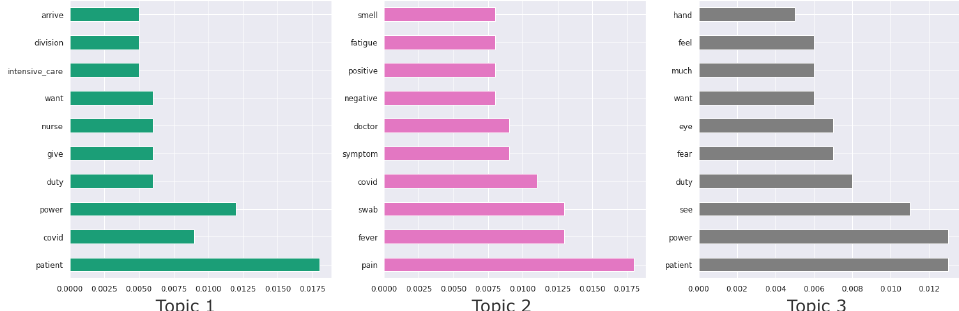
Figure 4. Bar plot of keywords and weight for each topic modeled through the LDA